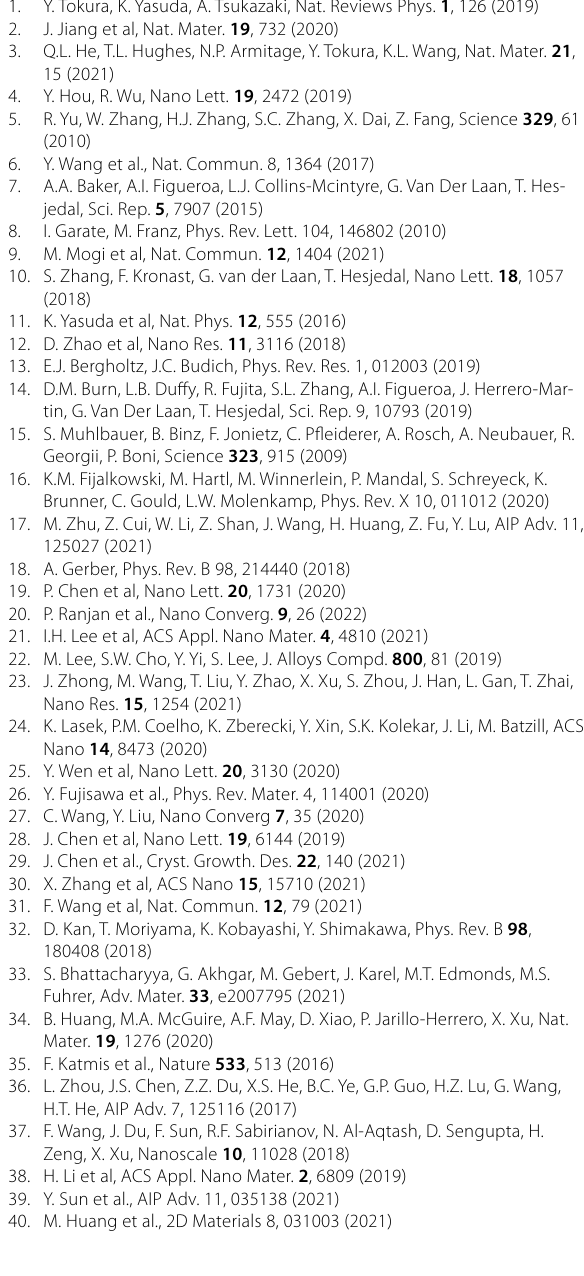
Additional file 1: Figure S1. TEM cross‑section image of CT/BSTS. Figure S2. Schematics of the electrical measurement Figure S3. Magnetoresist‑ ance vs. H curves of BSTS, CT, and CT/BSTS. Figure S4. Scheme of decom‑ posing the Hall resistivity. Figure S5. Separation of two AHE components at 50 – 90